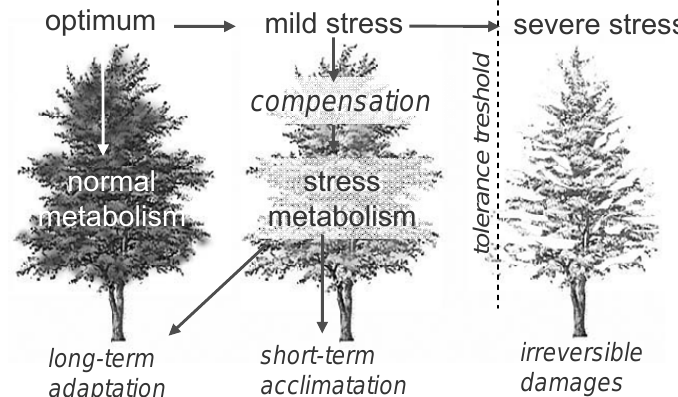
Figure 1. Stressor dose-stress effect relationships in